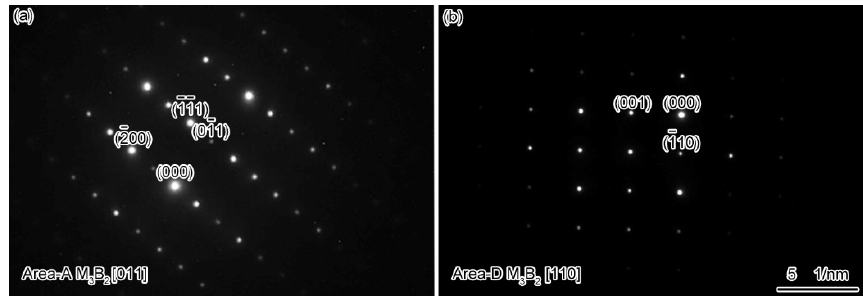
Figure 7. Identification of phases in the brazing joint: ( a ) Area-A M 3 B 2 ( b ) Area-D M 3 B 2. Table 2. EPMA analysis of different regions of the as-prepared and PBHT-processed joints ( at.% ).